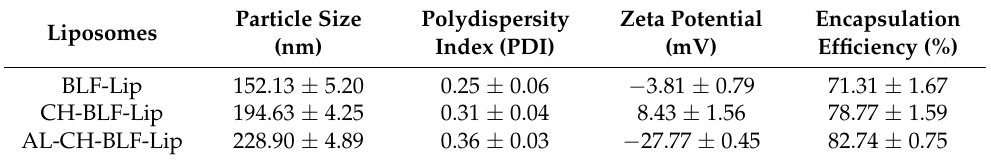
Table 1. Characterization of BLF-loaded nanoliposomes. BLF, bamboo leaf flavonoids; BLF-Lip, BLF- loaded nanoliposomes; CH-BLF-Lip, BLF-loaded chitosan coated nanoliposomes; AL-CH-BLF-Lip, BLF-loaded alginate-chitosan coated